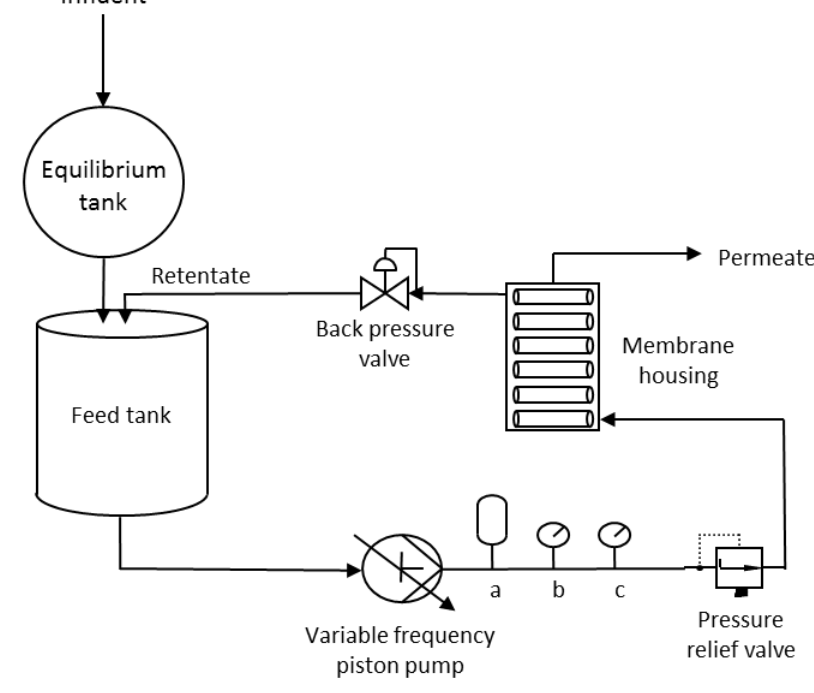
Figure 3. Process flow for membrane filtration experiment. a—Baffler; b—Temperature sensor; c—Pressure sensor.